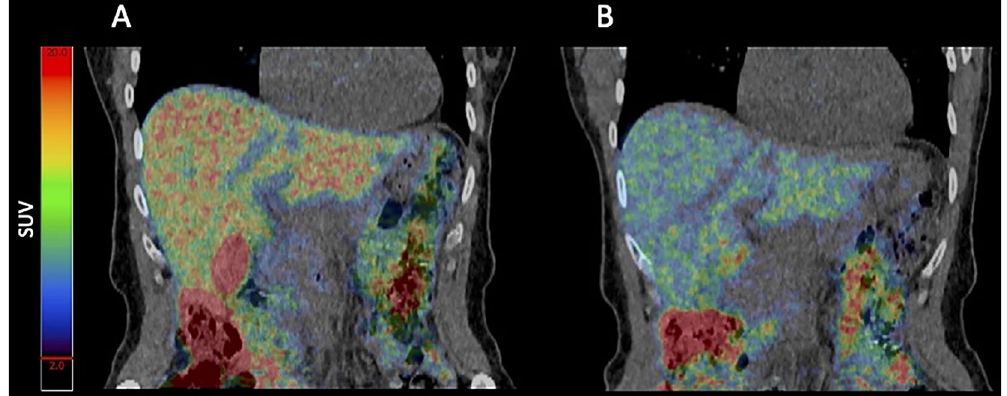
Figure 2. PET/CT scan 13 h after oral intake of 30 MBq copper-64. ( A ) Baseline scan. ( B ) End-of-treatment scan—after 4 weeks administration with zinc gluconate 50 mg × 3 daily.